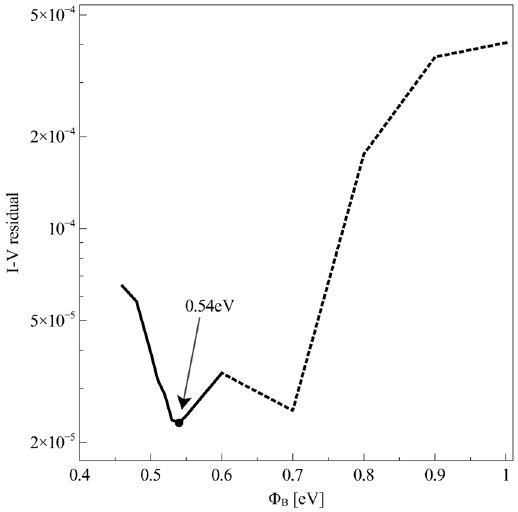
Figure 5. Residual of the least–squares fit of the OTFT transfer characteristic curves with contact resistance effects taken into account, at different values of the injection barrier Φ B . The solid line represents the range of barrier values that correspond to acceptable CF curves, as shown in Fig. 4a, while the dotted line is used for the range of barrier height values for which it is not possible to fit experimental CF curves and thus are to be considered